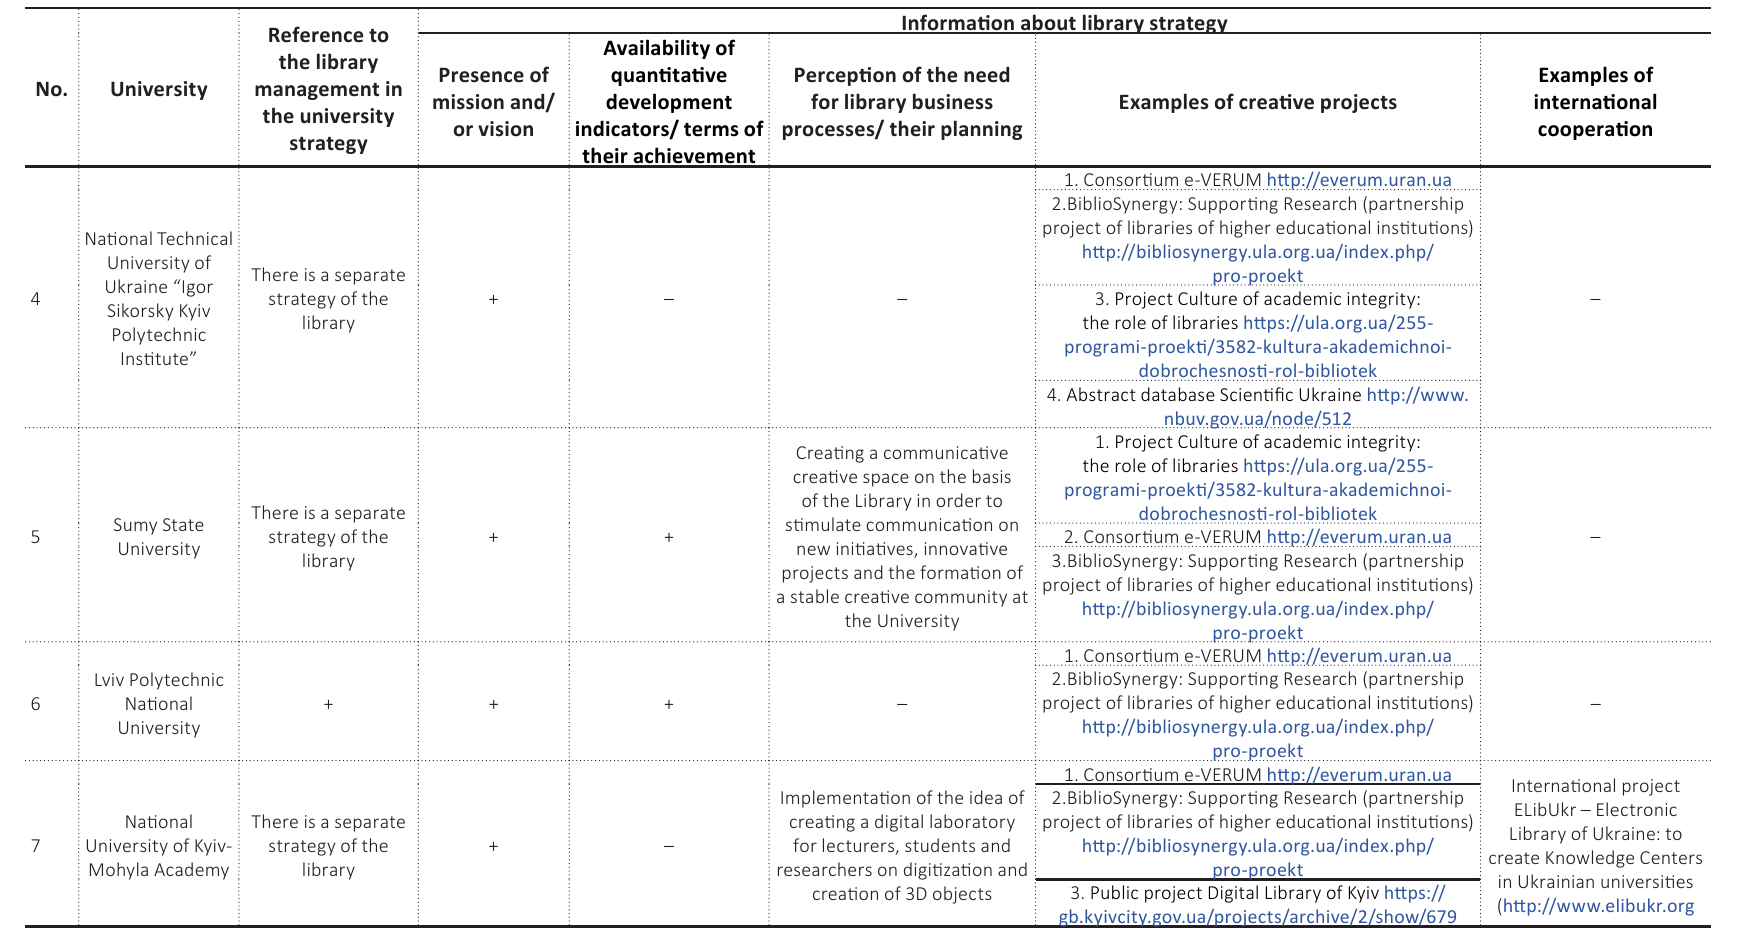
Table B1 (cont.). Analysis of strategies of university